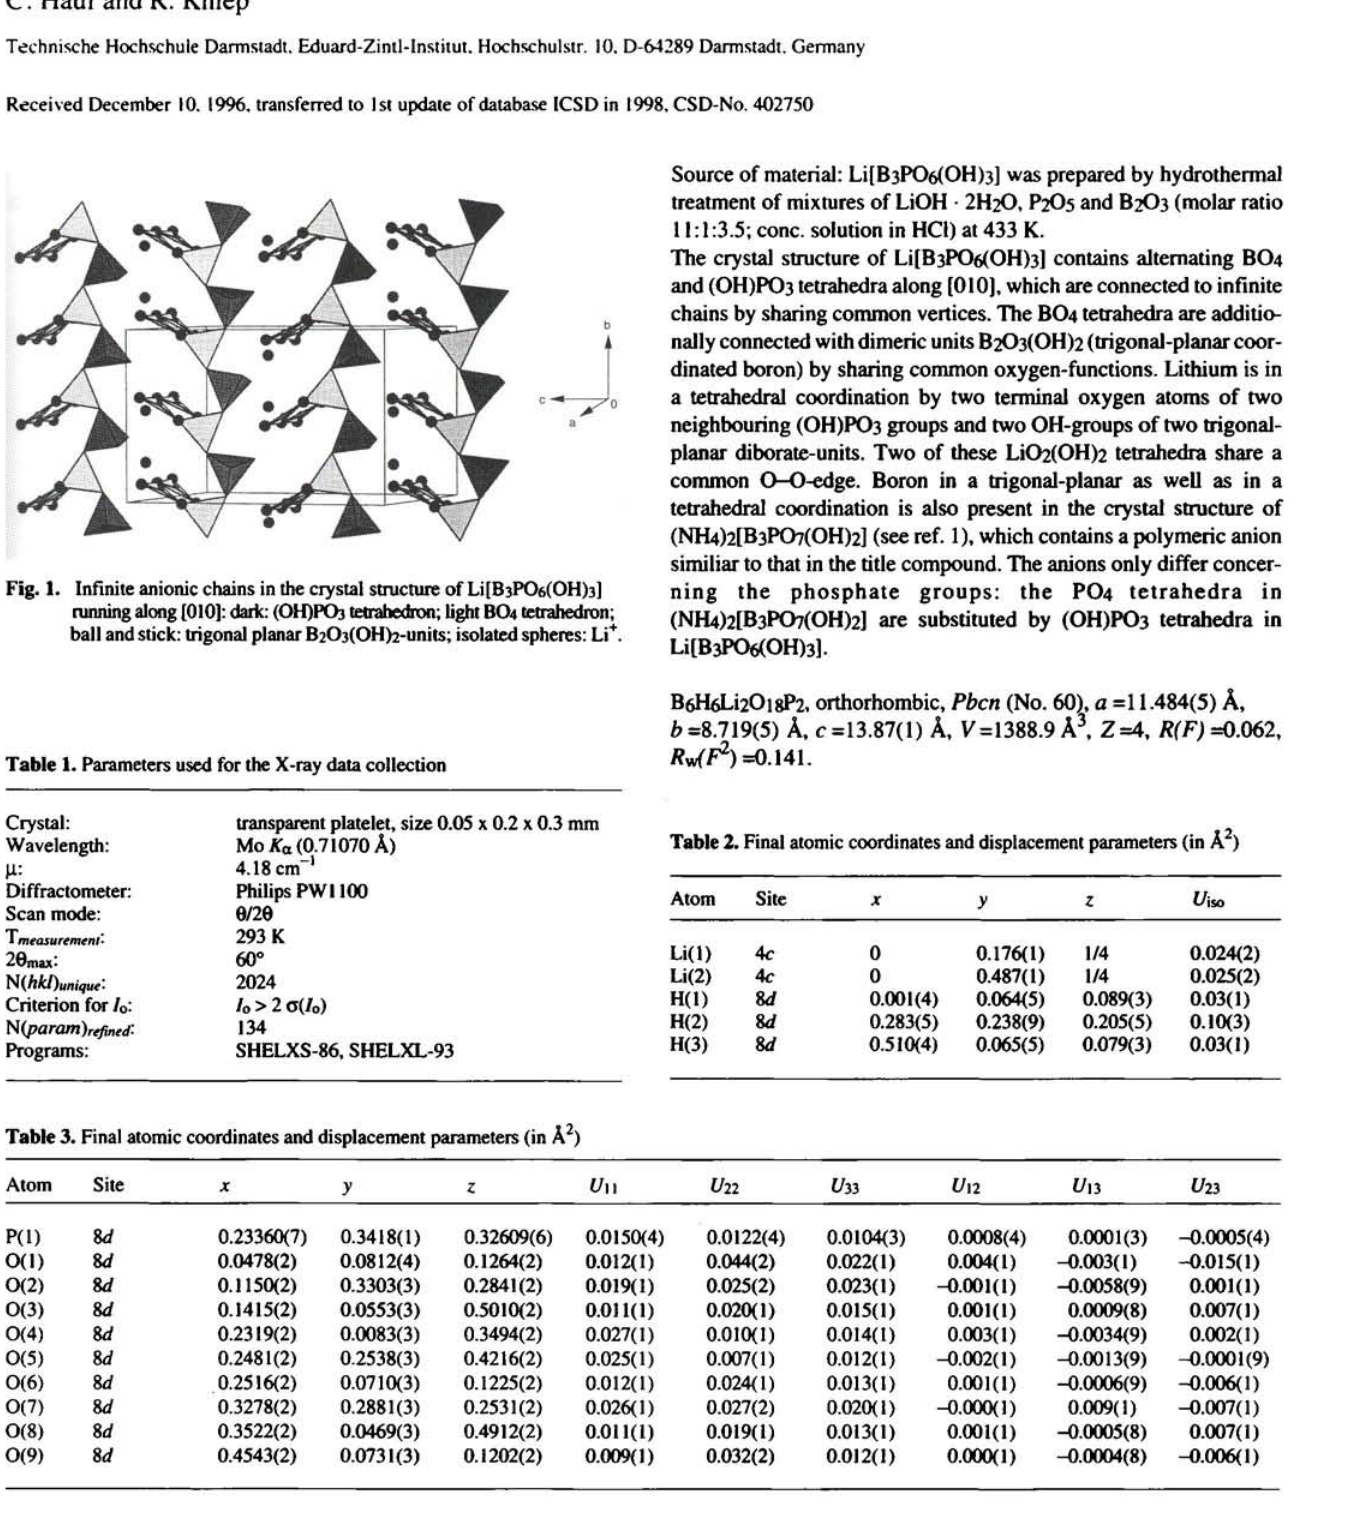
Table 3. Final atomic coordinates and displacement parameters (in Ä 2 ) Atom